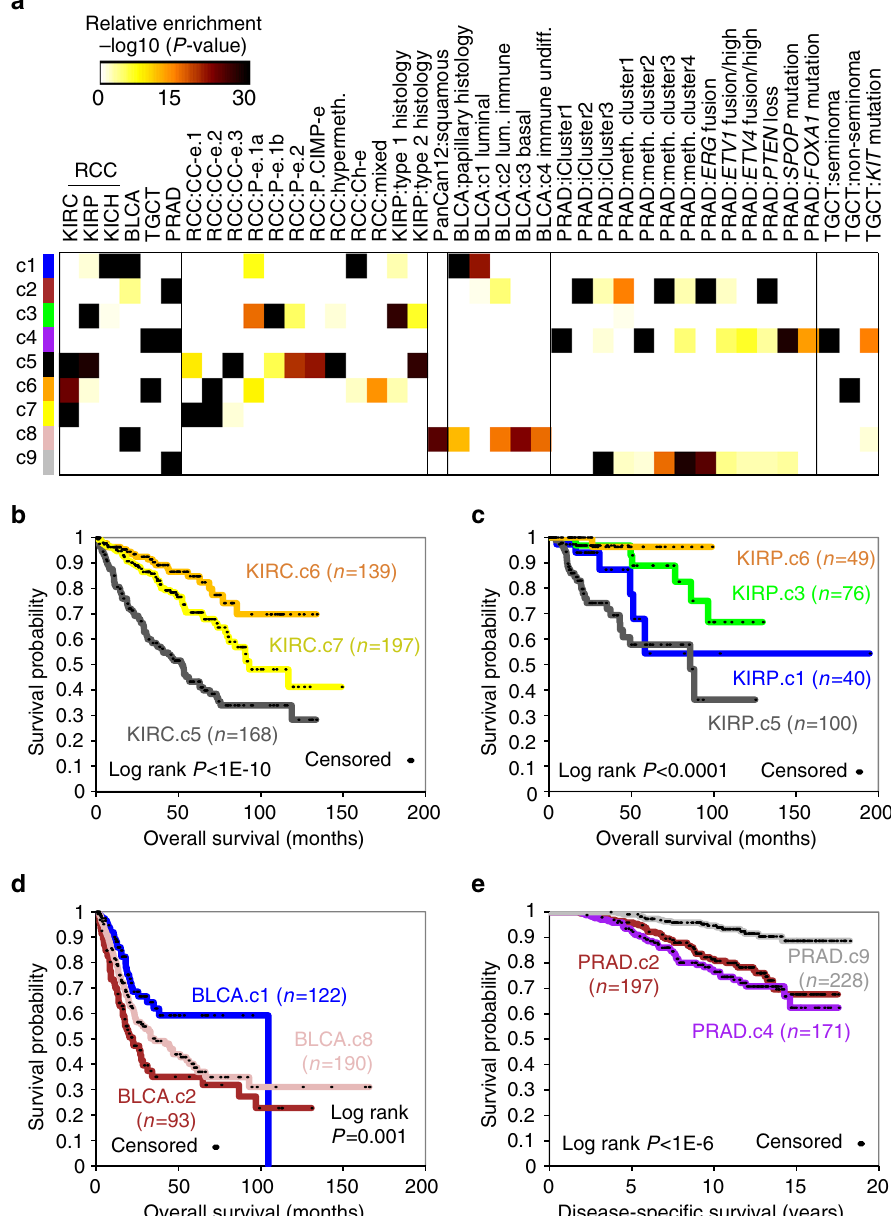
Fig. 3 Pan-urologic cancer genomic subtypes have analogs of previously described cancer type-speci fi c histological or molecular subtypes. a Signi fi cance of overlap between the pan-urologic cancer subtype assignments made in the present study (rows), with histological- or molecular-based subtype assignments (columns, also compiled in Supplementary Data 1) made previously 5,6,10 for a subset of cases. P -values by one-sided Fisher ’ s exact test. RCC , renal cell carcinoma (KICH, KIRC, KIRP). “ meth. ” and “ hypermeth. ” , DNA methylation and DNA hyper-methylation, respectively. “ lum. immune ” and “ immune undiff. ” , BLCA mRNA-based subtypes luminal immune and immune undifferentiated, respectively 17 . PanCan12:squamous associated with “ squamous ” pan-cancer subtype by Hoadley et al. 7 b Within TCGA KIRC cases, differences in patient overall survival among the pan-urologic c5, c6, and c7 genomic subtypes. c Within TCGA KIRP cases, differences in patient overall survival among the pan-urologic c1, c3, c5, and c6 genomic subtypes. d Within TCGA BLCA cases, differences in patient overall survival among the pan-urologic c1, c2, and c8 genomic subtypes. e Within an independent cohort of prostate cancer cases 18 , classi fi ed according to our pan-urologic genomic subtypes, differences in patient overall survival among the c2, c4, and c9 subtypes. For parts b-e, P -values by log-rank test. See also Supplementary Fig.